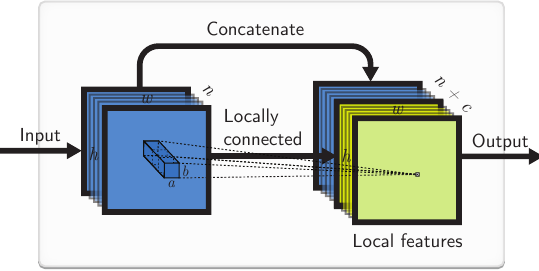
Figure 4. Implementation with a locally connected layer. Input goes through a locally connected layer b ) kernel and produces local features that are concatenated with the with a ( a ×